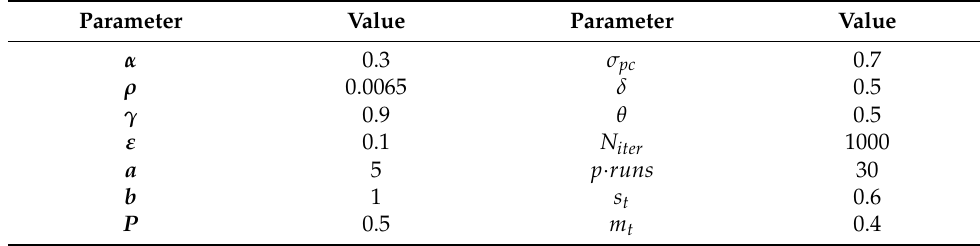
Table 1. Parameter settings of the